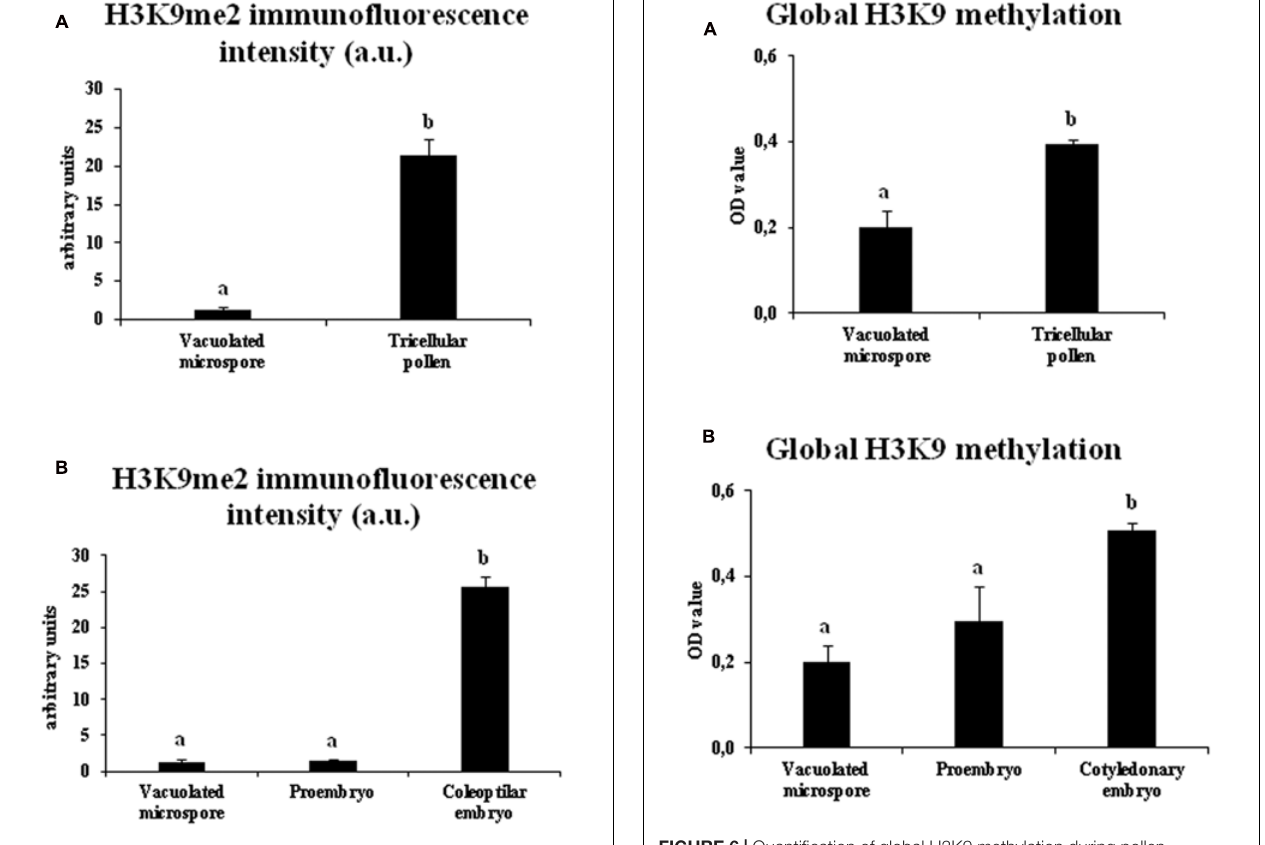
different stress treatments (hot temperature in rapeseed and cold temperature in barley).